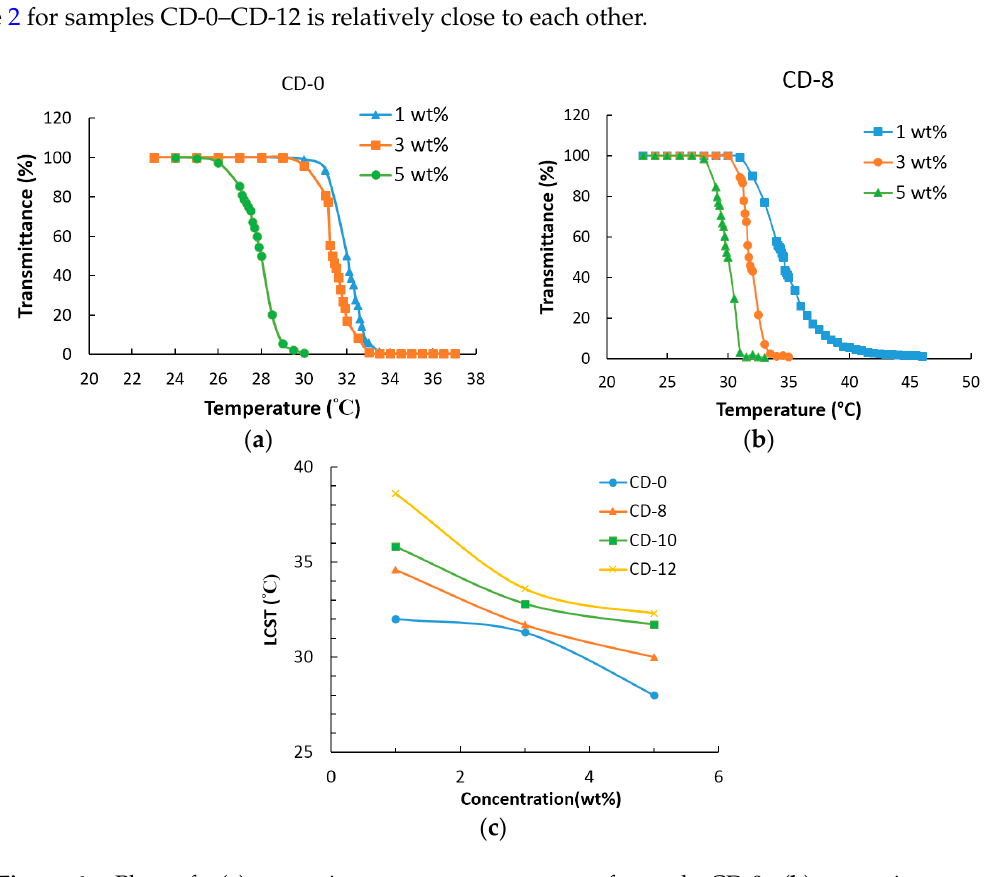
Figure 6. Plots of: ( a ) transmittance vs. temperature of sample CD-0; ( b ) transmittance vs. temperature of sample CD-8; and ( c ) lower critical solution temperatures (LCST) vs. concentration for poly(CD-NIPAM) and poly(CD-NIPAM-IAM)